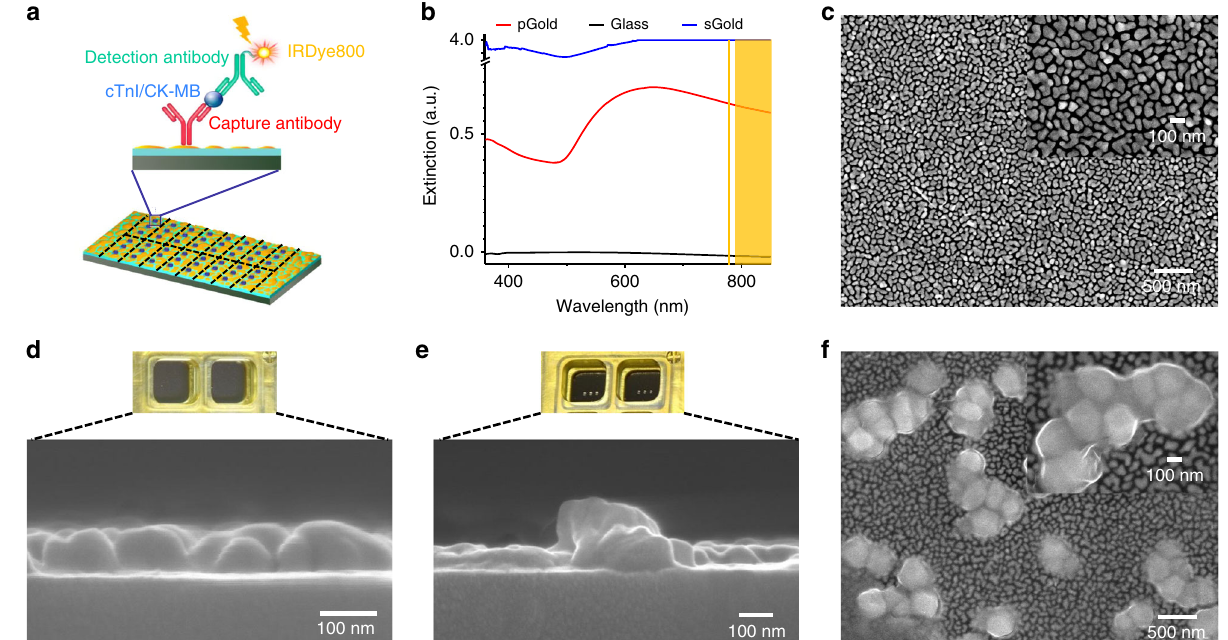
Fig. 1 Construction and characterization of antibody-printed pGold chips. a Schematic illustration of antigen (cTnI/CK-MB) detection on pGold chip using a sandwich assay. b Extinction spectra of pGold chip (red line), glass (black line), and sGold chip (blue line) overlaid with the excitation and emission (yellow shaded area) regions of IR800 dye. c Top-view SEM of pGold chip ( n ≥ 3 randomly selected). d Digital image of two bulk reaction wells and side- view SEM of gold islands on pGold chip. e Digital image of two antibody-printed reaction wells and side-view SEM of capture antibodies on pGold chip. f Top-view SEM of capture antibodies on pGold chip ( n ≥ 3 randomly selected). Insets of ( c ) and ( f ) were the zoomed SEM images. Source data are provided as a Source Data fi